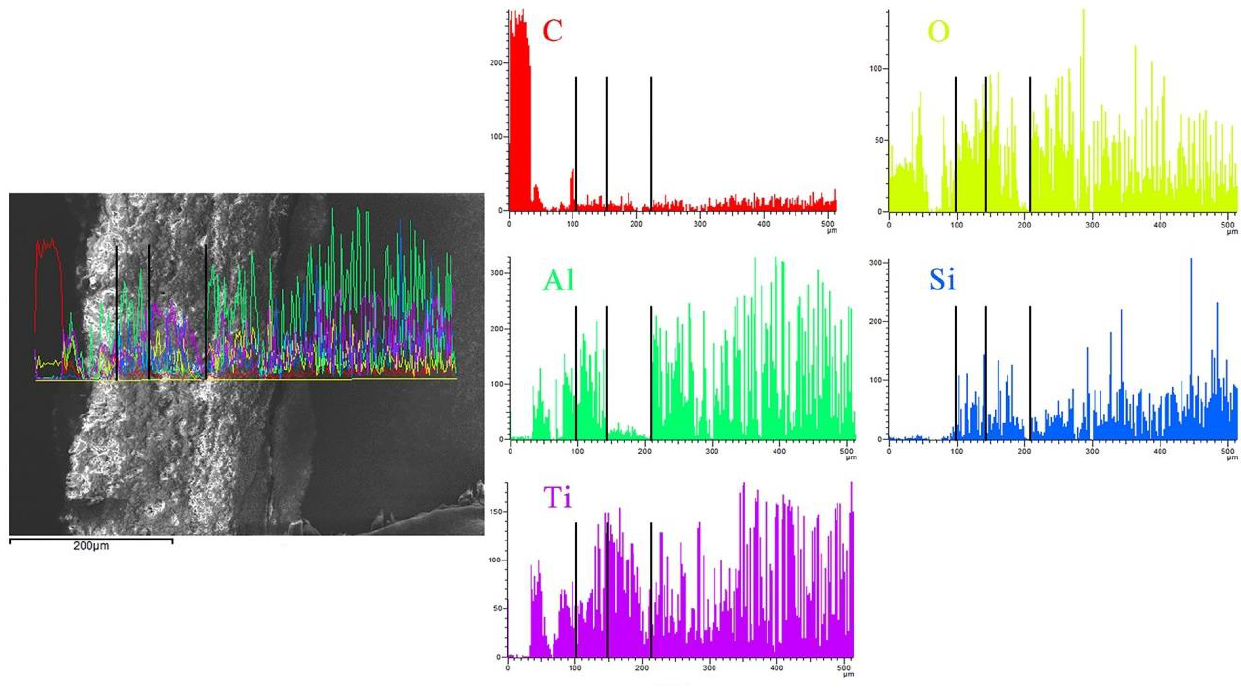
Figure 9. EDS line scanning results of TSC60 after oxidation at 1400 ◦ C for 20